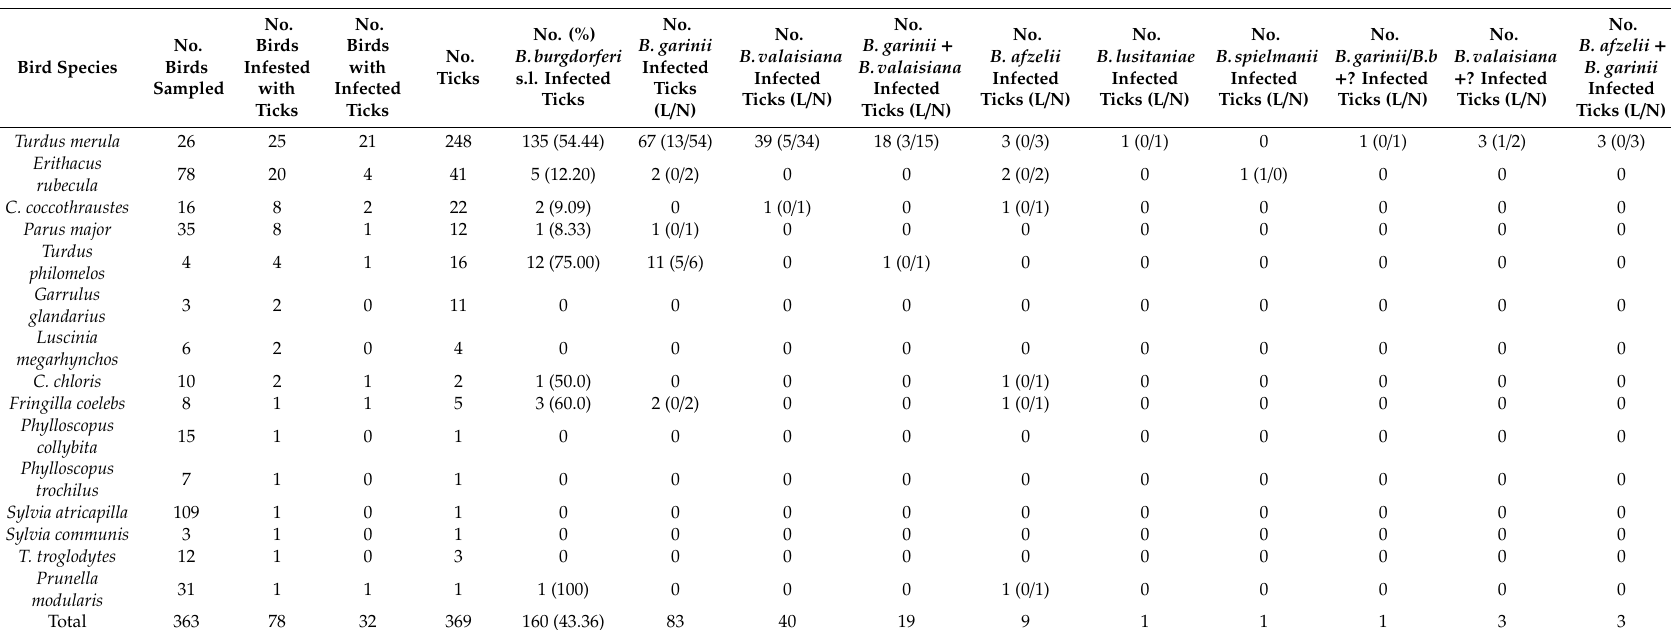
Table 1. Prevalence of Borrelia burgdorferi s.l. in Ixodes ricinus ticks feeding on birds at a study site in Slovakia, 2017. L and N refer to larvae and nymphs, respectively. Restriction Fragment Length Polymorphism (RFLP) was used to diagnose the genospecies of borreliae. Since ticks from the same birds were stored in single tubes, the possibility of sample contamination cannot be excluded, and the prevalences reported should be considered as maximum infection